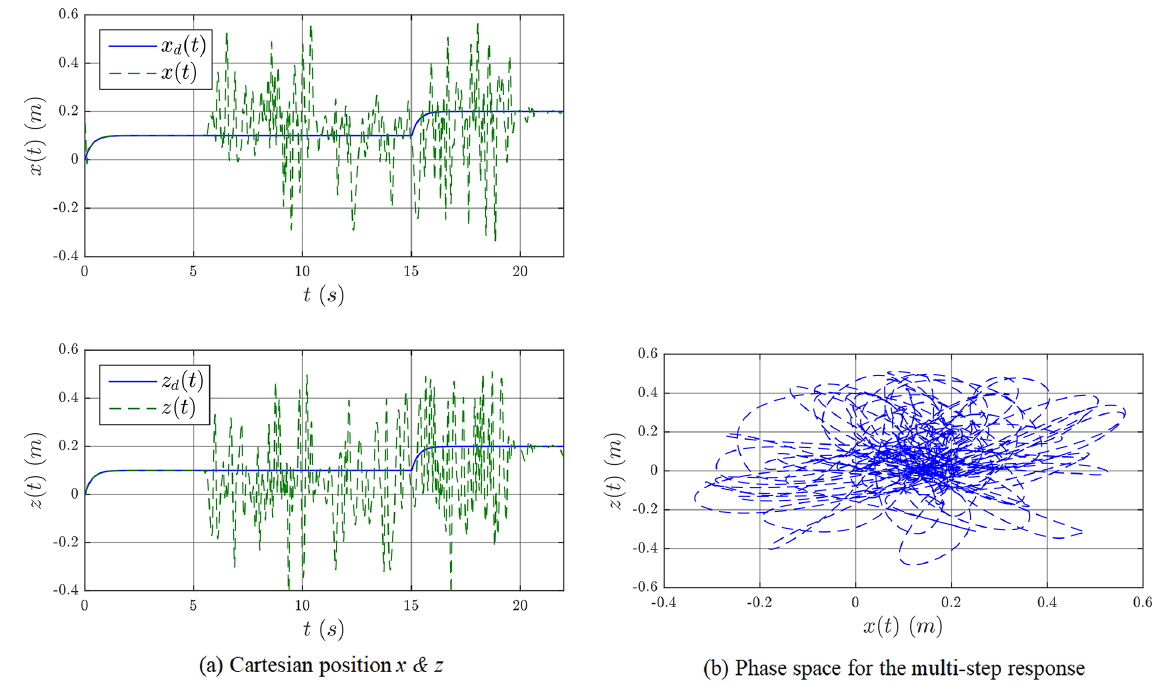
Figure 9. The Cartesian positions x and z without the proposed adaptive chaos control law for the multi-step response.